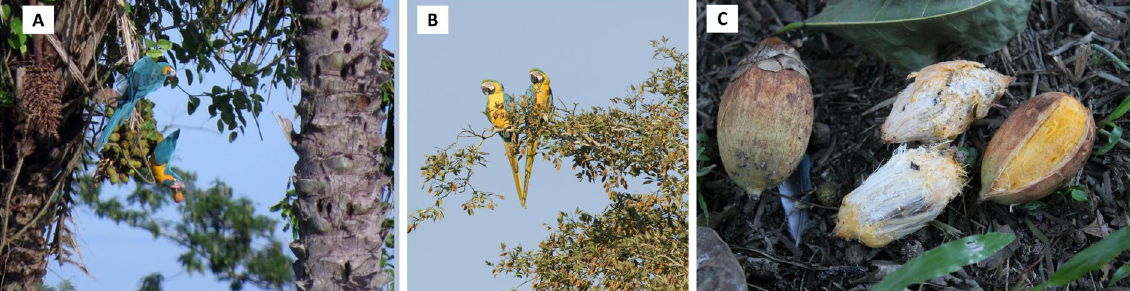
Figure 3. Dispersal of motacú fruits by macaws. ( A ) Two blue-throated macaws Ara glaugogularis feeding on a motacú palm; note the individual with a fruit in the beak before flying and dispersing the fruit until a perching place. ( B ) Two blue-and-yellow macaws Ara ararauna resting in a perching tree where they typically handle the dispersed fruits. ( C ) One ripe motacú fruit (left), two fully defleshed (center) and one partially defleshed (right) fruit found under perching trees after being dispersed and handled by macaws. Note macaws just eat the pulp, leaving intact the nut which contains viable seeds from ripe fruits. Photographs taken by J.A. Díaz-Luque –Fundación para la Conservación de los Loros de Bolivia ( A , C ) and J.L. Tella ( B ).